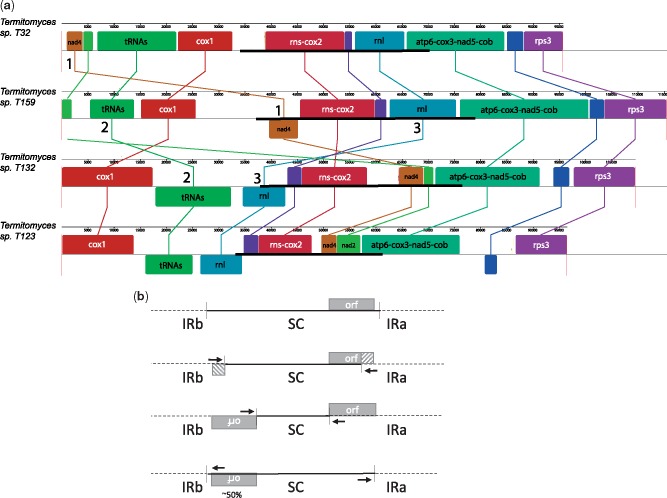
—(A) Mauve alignment of four Termitomyces mitochondrial genomes: sp. T32 (used as reference), T159, T132, and T123. Colored blocks indicate predicted homologies, which are connected through vertical lines. Genes associated with homologous regions are indicated in text for each block. If a block is shown underneath the line it indicates an inversion with respect to the reference. The inverted repeat is represented by a bold line for each genome (only one copy is shown). Several rearrangements are likely due to contraction/expansion of the inverted repeat: 1) The movement of nad4 from an upstream position of cox1 in SC1 of sp. T32 to the IR in the other species is probably a result of either contraction or expansion; 2) the repositioning of a large tRNA island from an upstream position of cox1 in sp. T32 and T159 to a downstream position in sp. T132 and T123 most likely involved both contraction and expansion; 3) the large ribosomal subunit (rnl) is only partially included in the IR in sp. T132 and T123, showing a potential expulsion or enveloping in progress. (B) Example of gene translocation through successive inclusion and expulsion by the IR (Goulding et al. 1996). When the IR expands, for instance through illegitimate recombination, it can overlap a flanking ORF. This creates a copy of the overlapping part of the ORF on the opposite IR. The ORF may even end up completely within the IR, in which case two complete copies of the ORF are created. When the IR shrinks and expunges the ORF, one of the copies will disappear, resulting in an ∼50% chance of the ORF translocating to a new position.